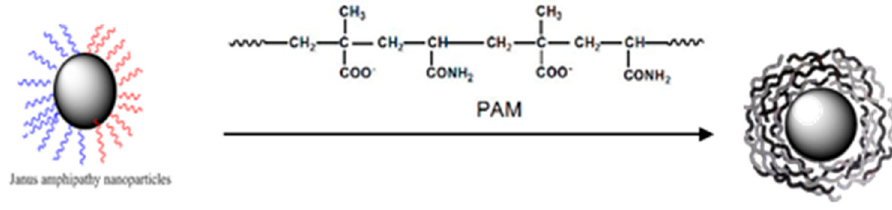
Figure 4. Self-assembly process of microcapsules and nanocapsules.